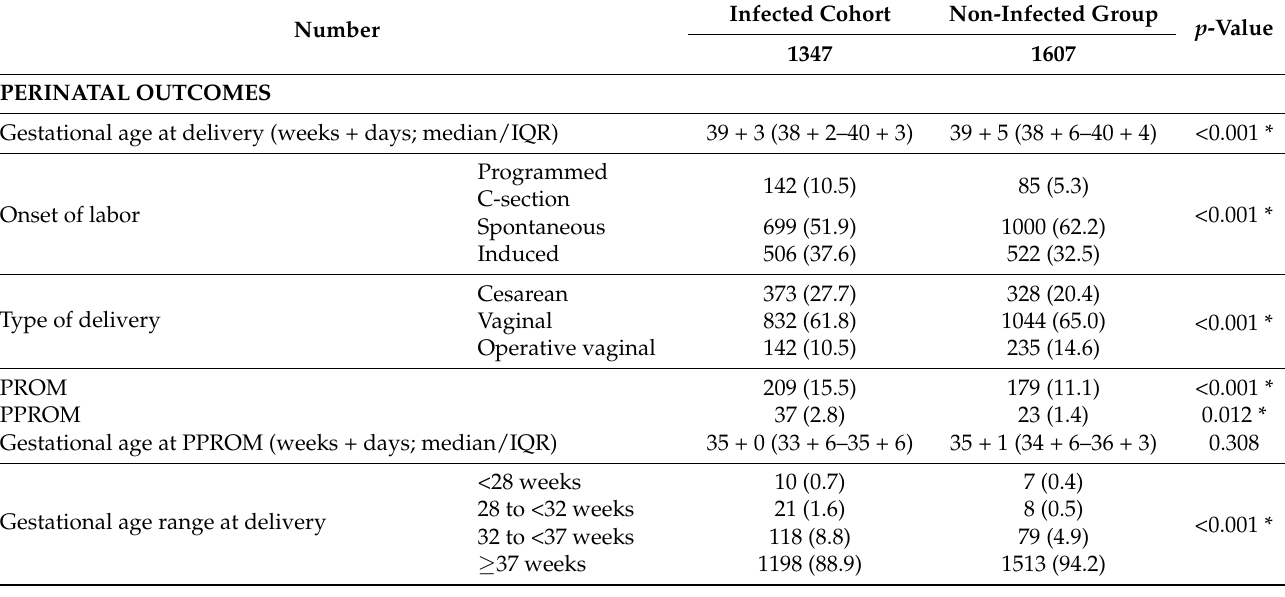
Table 2. Maternal and neonatal outcomes of the study participants ( n =